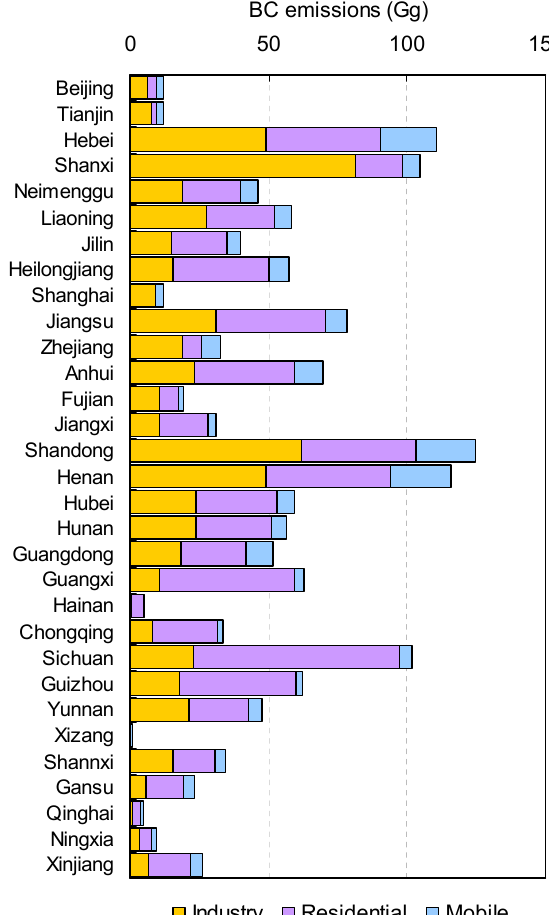
Fig. 8. Provincial BC emissions in 2005.